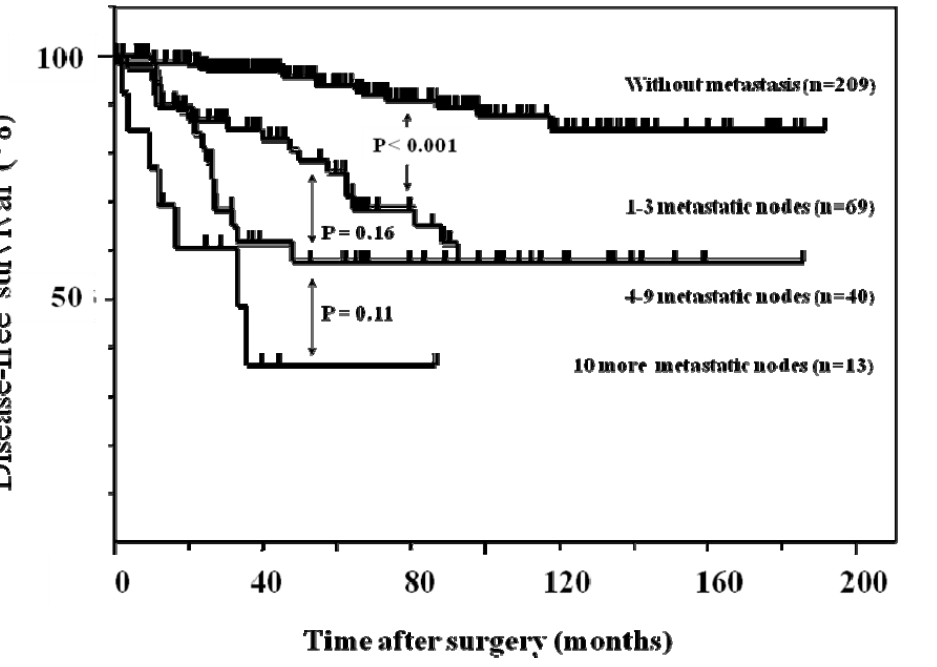
Figure 2. Five-year disease-free survival curves according to the number of lymph node metastases by